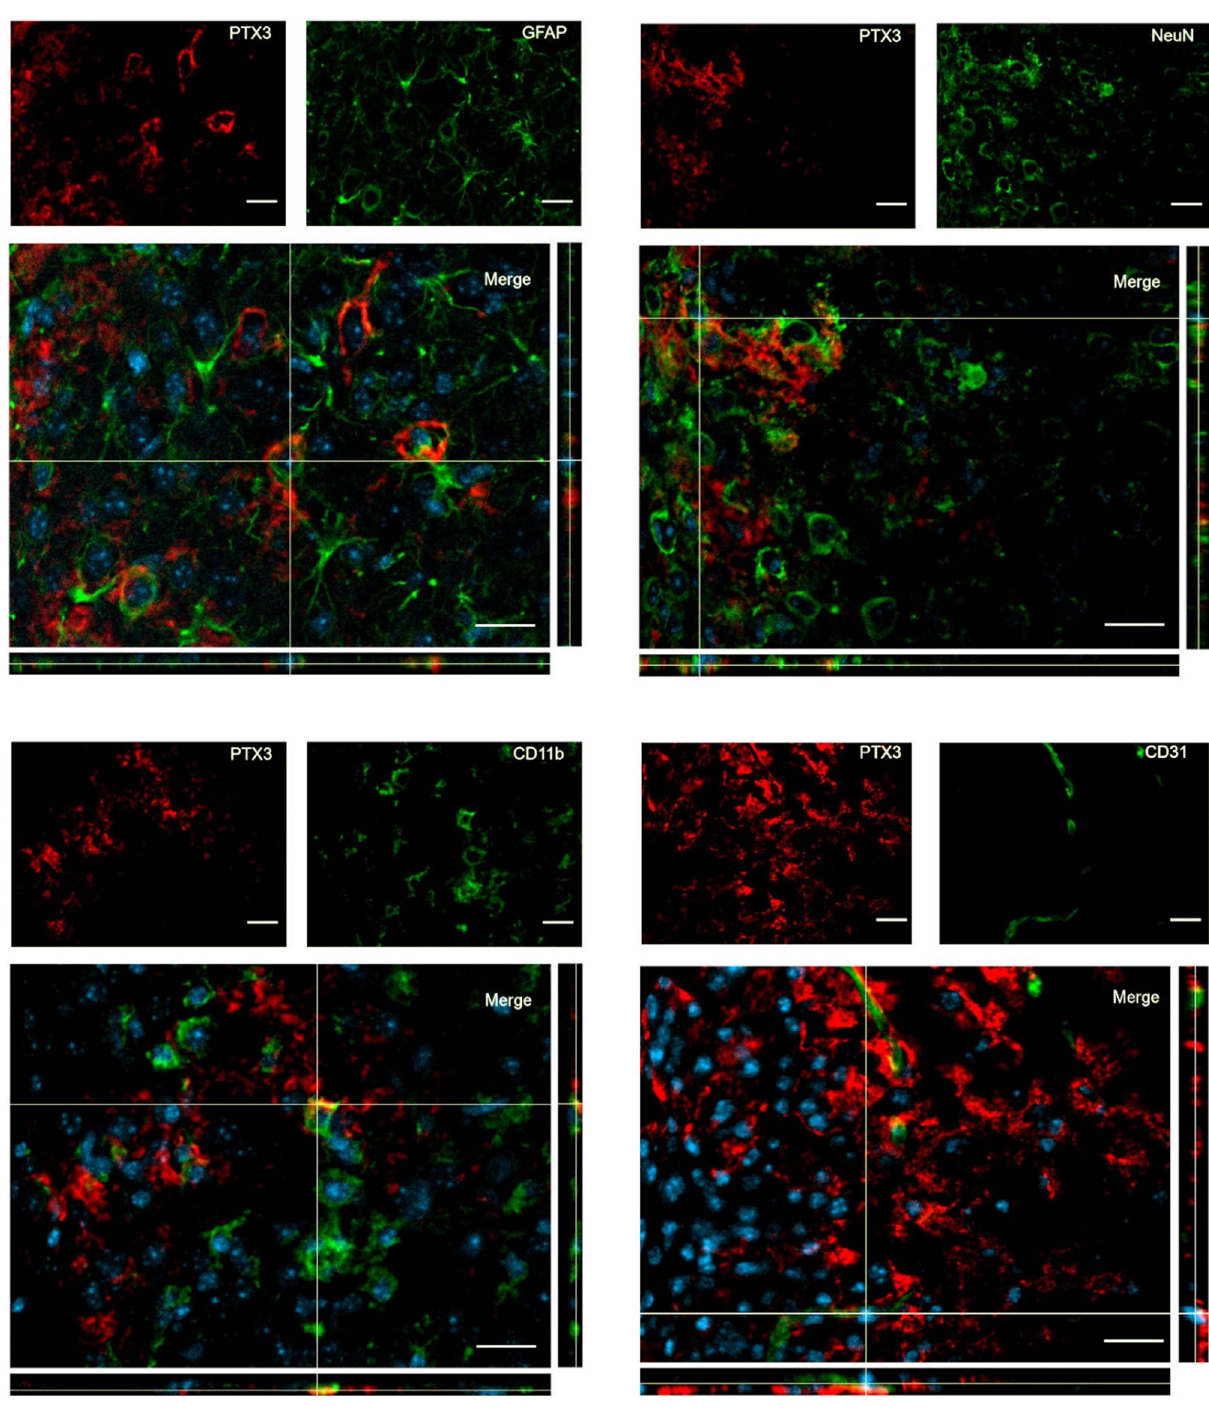
Figure 5. Confocal analysis of PTX3 presence in the contused cortex 1 week after TBI. PTX3 (red) was present next to but did not co-localize with astrocytes (GFAP, green), neurons (NeuN, green), microglia (CD11b, green) and endothelial cells (CD31, green). Nuclei are in blue. Images are representative of at least two independent experiments. Scale bar = 20